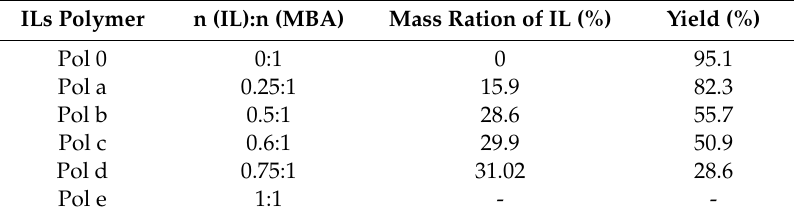
Table 1. The elemental analysis results. Table 2. The recipe of IL Pols and their EA analysis results.